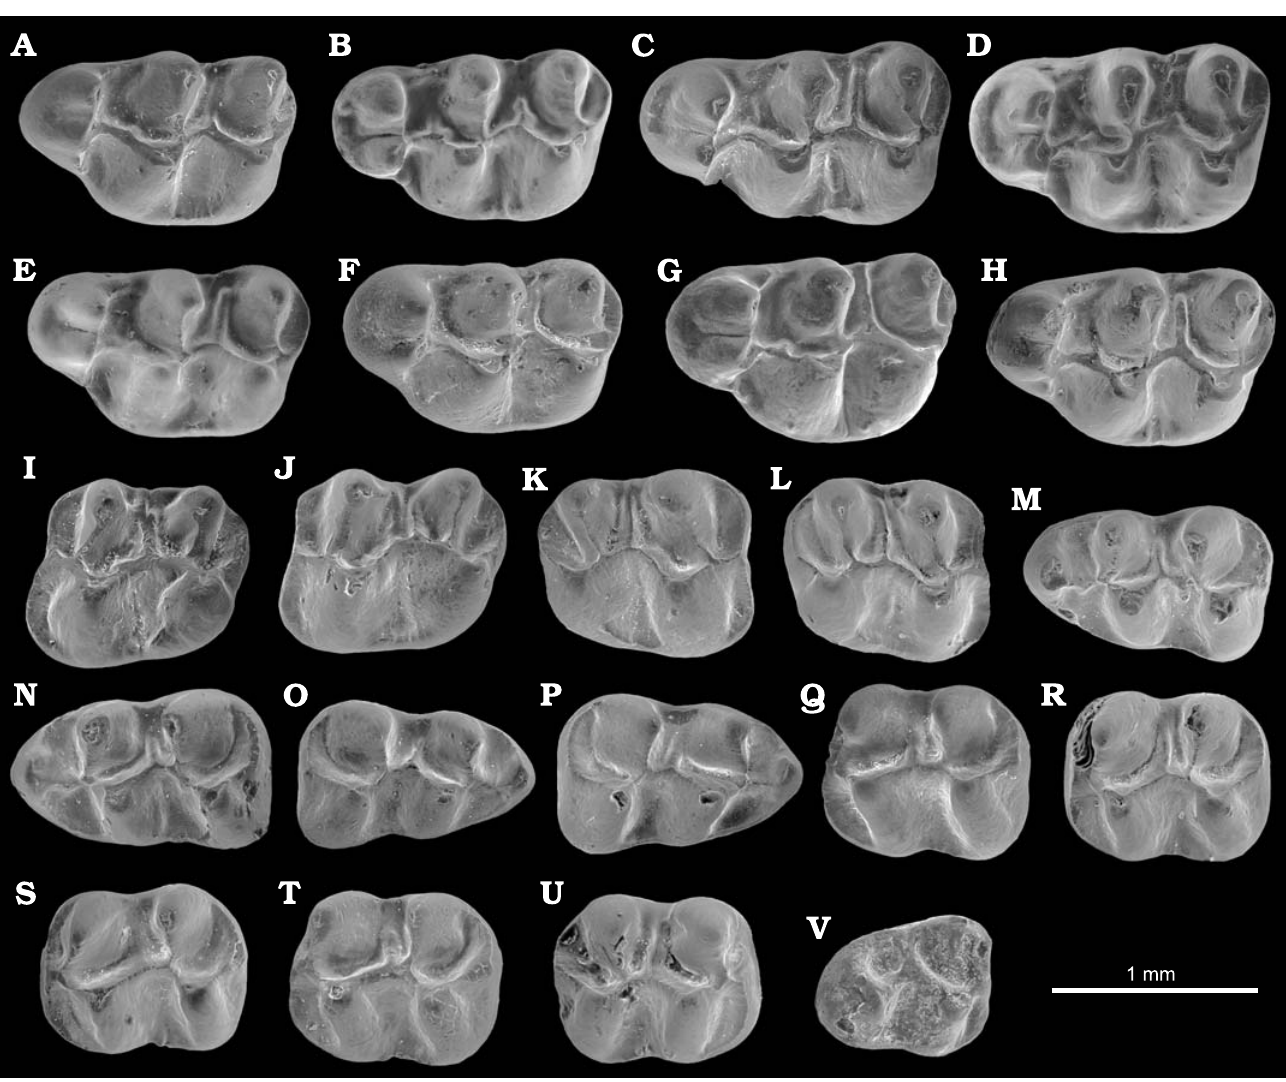
Fig. 1. Cricetodontid rodent Megacricetodon hellenicus sp. nov. from type locality Aliveri North quarry, Greece (MN4, Early Miocene). A . IAUU AL-N-2051, M1 left. B . IAUU AL-N-2052, M1 left. C . IAUU AL-N-2053, M1 left. D . IAUU AL-N-2055, M1 left. E . IAUU AL-N-2056, M1 left. F . IAUU AL-N-2057, M1 left. G . IAUU AL-N-2059, M1 left. H . IAUU AL-N-2060, M1 left. I . IAUU AL-N-2071, M2 left. J . IAUU AL-N-2072, M2 left. K . IAUU AL-N-2077, M2 right. L . IAUU AL-N-2078, M2 right. M . IAUU AL-N-2091, m1 left. N . IAUU AL-N-2092, m1 left. O . Holotype IAUU AL-N-2096, m1 right. P . IAUU AL-N-2097, m1 right. Q . IAUU AL-N-2101, m2 left. R . IAUU AL-N-2102, m2 left. S . IAUU AL-N-2104, m2 left. T . IAUU AL-N-2105, m2 left. U . IAUU AL-N-2111, m2 right. V . IAUU AL-N-2126, m3